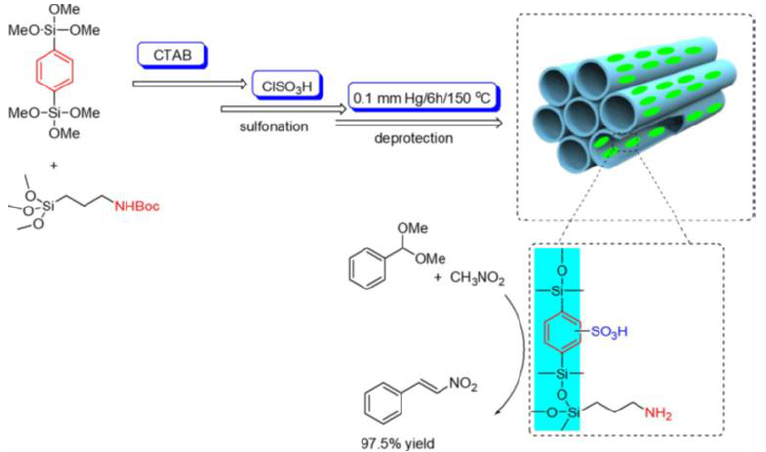
Figure 15. Synthesis of a bi-functionalized PMO for nitroaldol catalytic reactions [52,84]. Reprinted with permission from [52]. Copyright 2018, John Wiley and Sons.